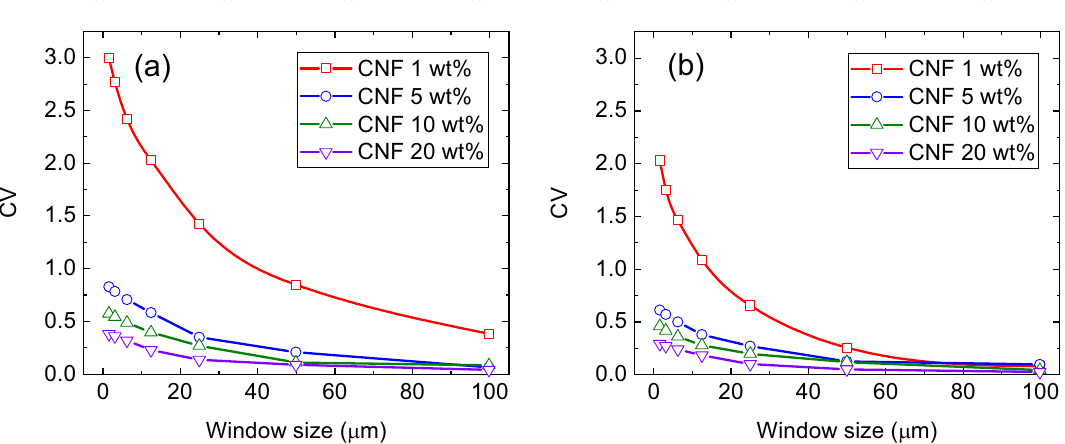
Figure 5. Relationship between window size of averaging filter and coefficient of the variance in integrated absorbance ratio; ( a ) Block-PP/CNF, ( b )